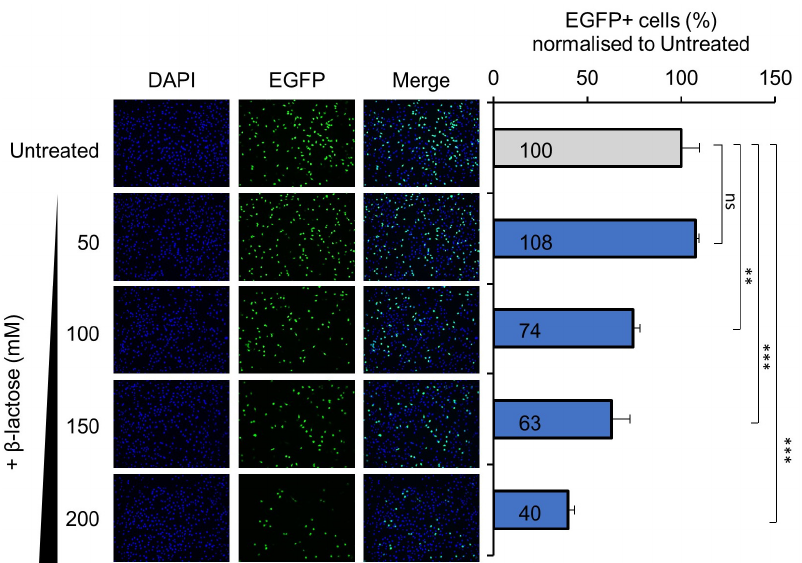
Figure 2. Pre-treatment with lactose decreases H-1PV infection in a dose-dependent manner. HeLa cells were pre-treated with the indicated concentrations of β -lactose for 30 min and then infected with recH-1PV-EGFP for 4 h. At 20 h after infection, cells were then harvested and processed as described in the Materials and Methods section. Numbers represent the arithmetic mean percentage of EGFP-positive cells relative to the number of EGFP-positive cells observed in untreated cells, which was arbitrarily set as 100%. The independent experiment shown was repeated thrice each with three biologically independent samples ( ns–not significant; ** p > 0.05; *** p ≤ 0.001, calculated by using a one-way ANOVA).